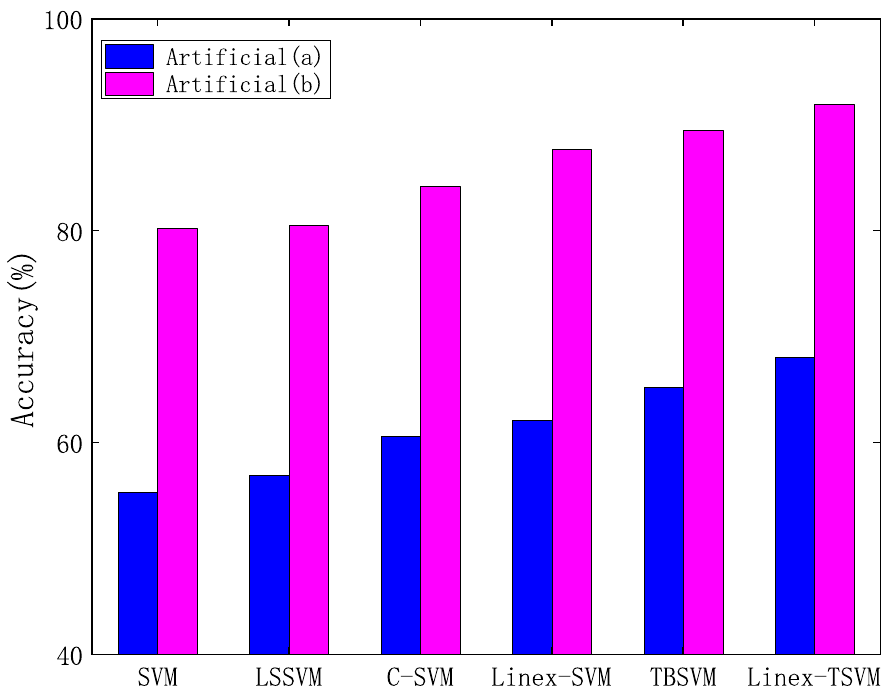
Figure 3. Accuracy of the two artificial datasets with